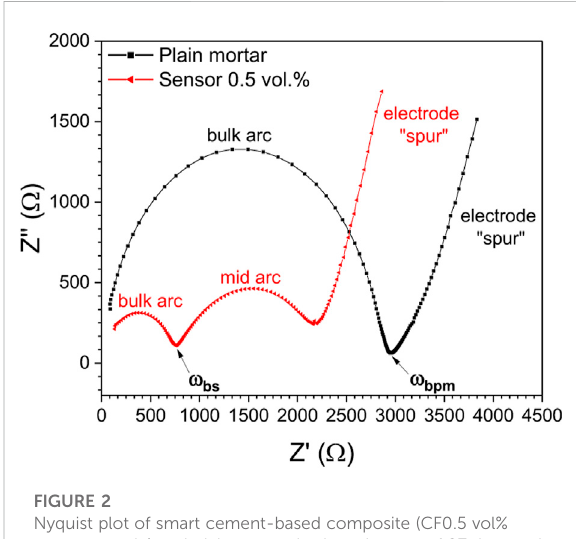
FIGURE 2 Nyquist plot of smart cement-based composite (CF0.5 vol% as an example) and plain mortar both at the age of 97 days and water-saturated condition, ω bs refers to the angular frequency for the bulk resistance of the smart cement-based composite, ω bpm refers to the angular frequency for the bulk resistance of the plain